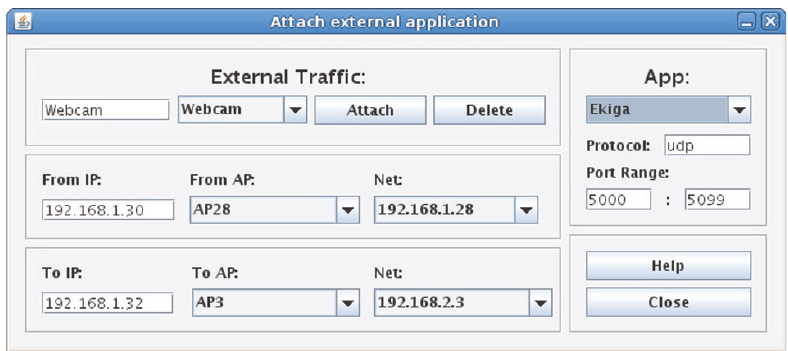
Figure 10: External tra ffi c declaration.